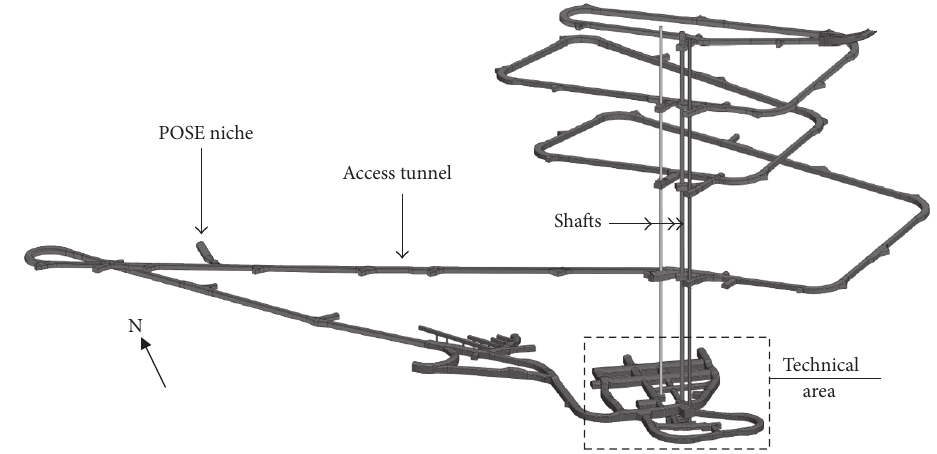
Figure 1: Layout of ONKALO with POSE niche, access tunnel, the shafts, and the technical area.